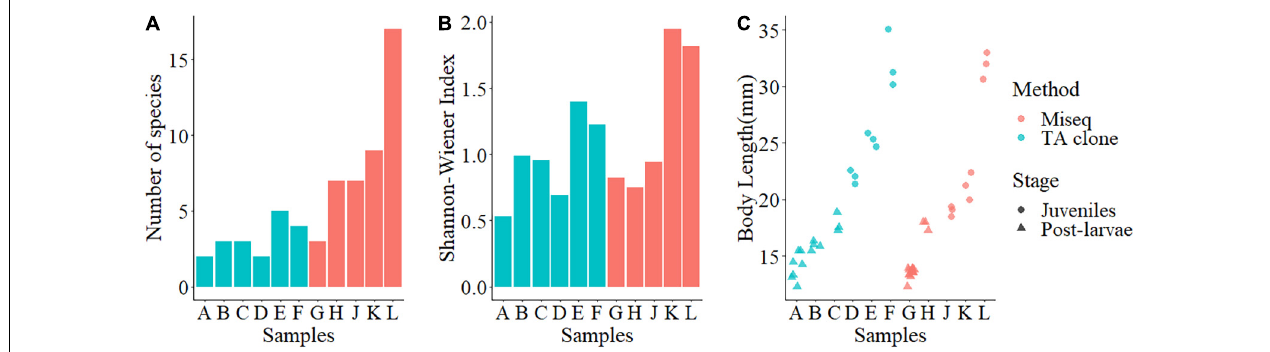
FIGURE 2 | Prey species richness, prey diversity, and body length of post-larval and juvenile small yellow croakers (Larimichthys polyactis) . (A) Prey species richness; (B) Prey diversity; (C) Body length. Red indicates samples analyzed using MiSeq, and blue indicates samples analyzed using TA cloning. In panels (A,B) , bars A, B, C, G, and H show post-larva, and bars D, E, F, J, K, and L show juveniles. In panel (C) , triangles represent post-larva, and dots represent juveniles.